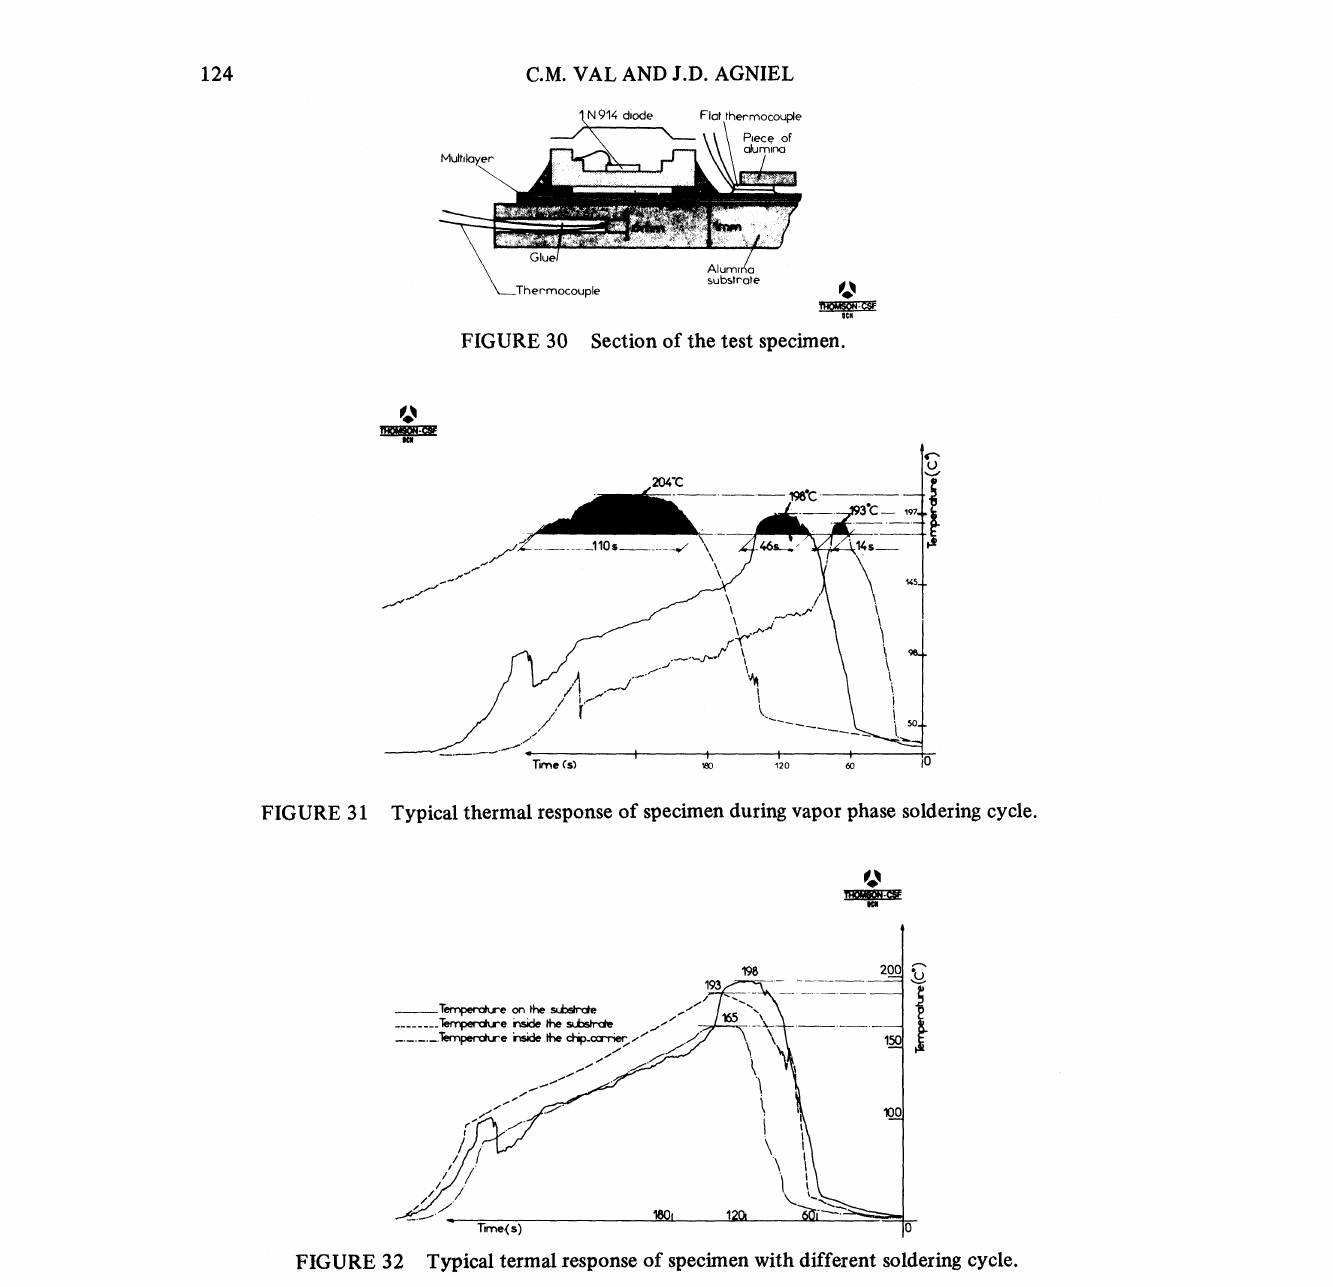
FIGURE 30 Section of the test specimen.